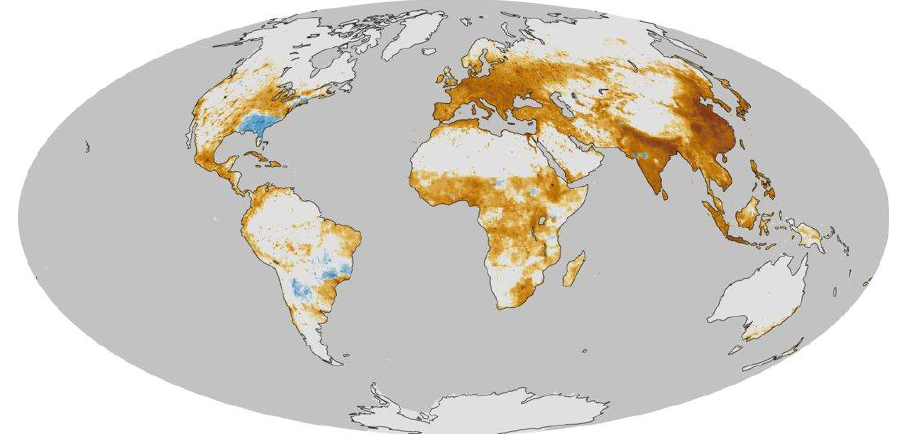
Figure 2. The map presented by the National Aeronautics and Space Administration (NASA) shows the air pollution related mortality rates worldwide (in contrary to the dark brown areas, the blue areas are those where the air quality has been improved and the related death rate has declined)